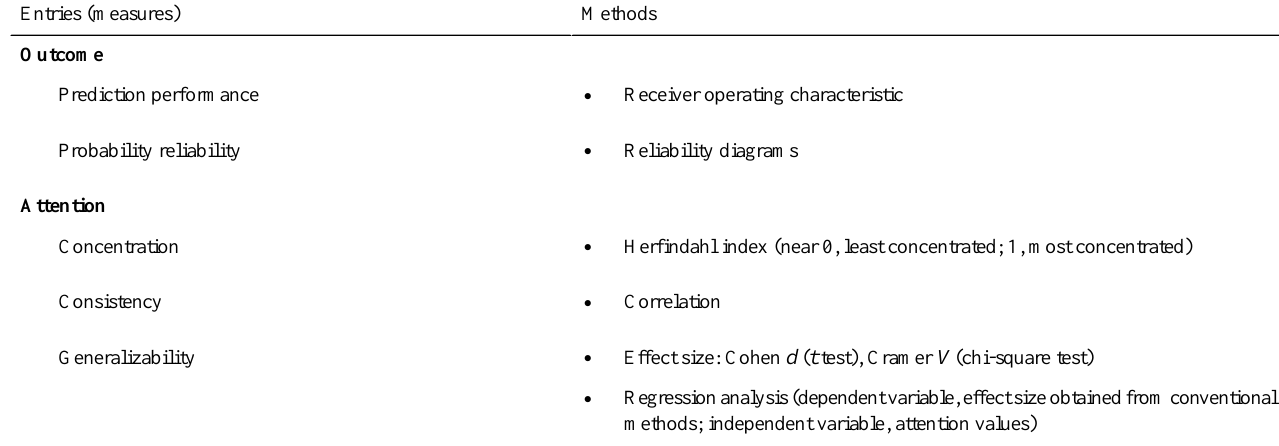
Table 1. Empirical test entries for measuring the performance of four models.